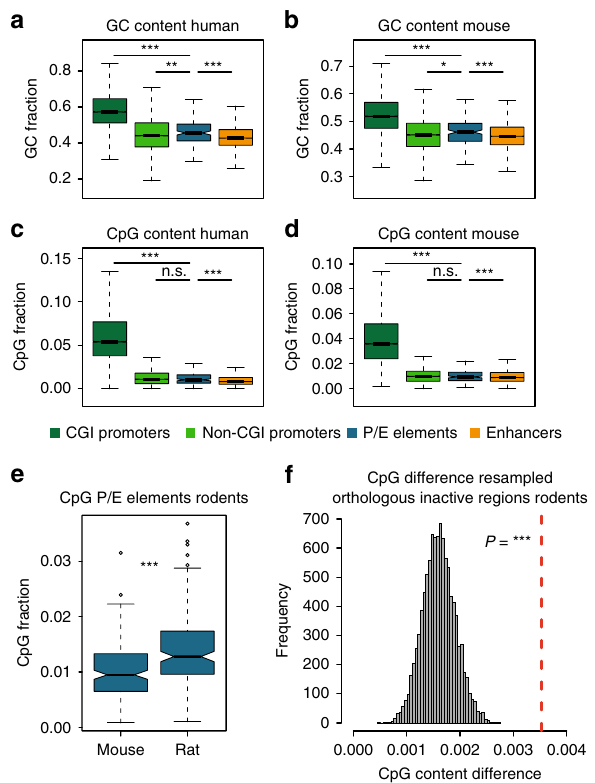
Fig. 3 Nucleotide composition of P/E elements. a – d Distribution of GC and CpG content for different classes of regulatory elements in human and mouse. Whiskers up to 1.5 times the interquartile range; outliers removed for graphical purposes. Signi fi cant differences (Mann – Whitney U -test with Benjamini-Hochberg correction): ∗∗∗ P < 0.001; ∗∗ P < 0.01; ∗ P < 0.05; (n.s.) P ≥ 0.05. e Distribution of CpG dinucleotide frequency in orthologous rodent P/E elements. Whiskers up to 1.5 times the interquartile range. f CpG frequency difference measured between orthologous inactive regions. The distribution was obtained by resampling 10,000 times a number of orthologous inactive regions equal to the number of P/E elements in d and calculating the average CpG frequency difference. The red line indicates the mean CpG frequency difference between orthologous rodent P/E elements. The P -value indicates the fraction of resampled inactive regions with an average CpG frequency higher than that of P/E elements ∗∗∗ P <